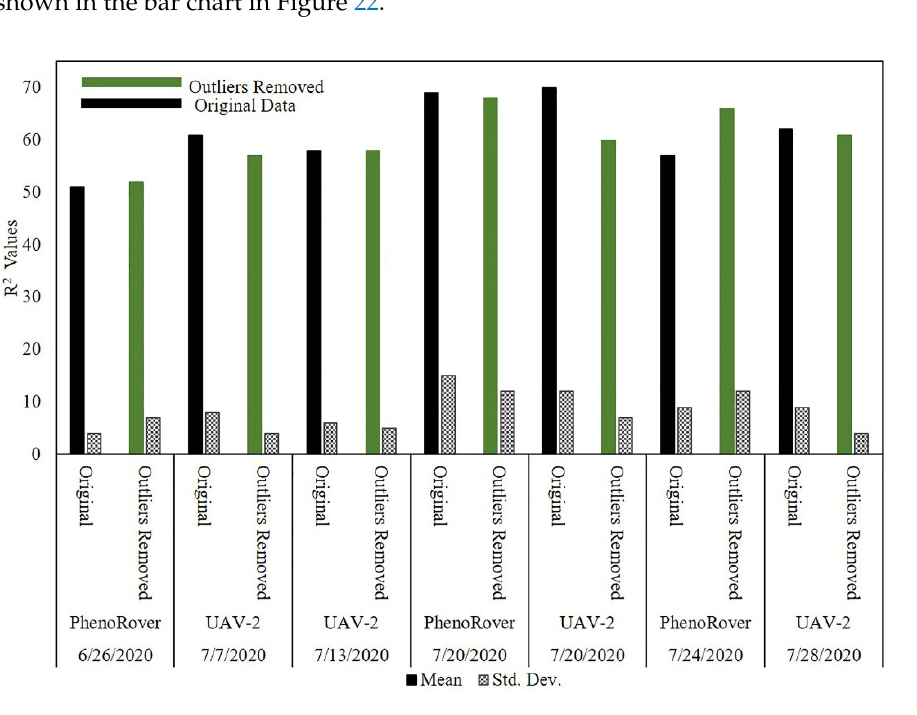
Figure 23. Plot of estimated LAI vs. ground reference: ( a ) original and ( b ) with outliers removed from PhenoRover data (7/24/2020) using PointCleanNet method. The results showed that the effect of outliers on PhenoRover data is higher than the UAV data based on the R 2 value improvement after outlier removal. The R 2 values result- ing from denoising the UAV data decreased, but the standard deviation of R 2 was also reduced. This implies that outlier removal reduced the anomalous data in terms of im- proving the LAI estimation, but that useful points were also removed. Overall, t-tests of the improvement related to the impact of outlier removal indicated that the change was